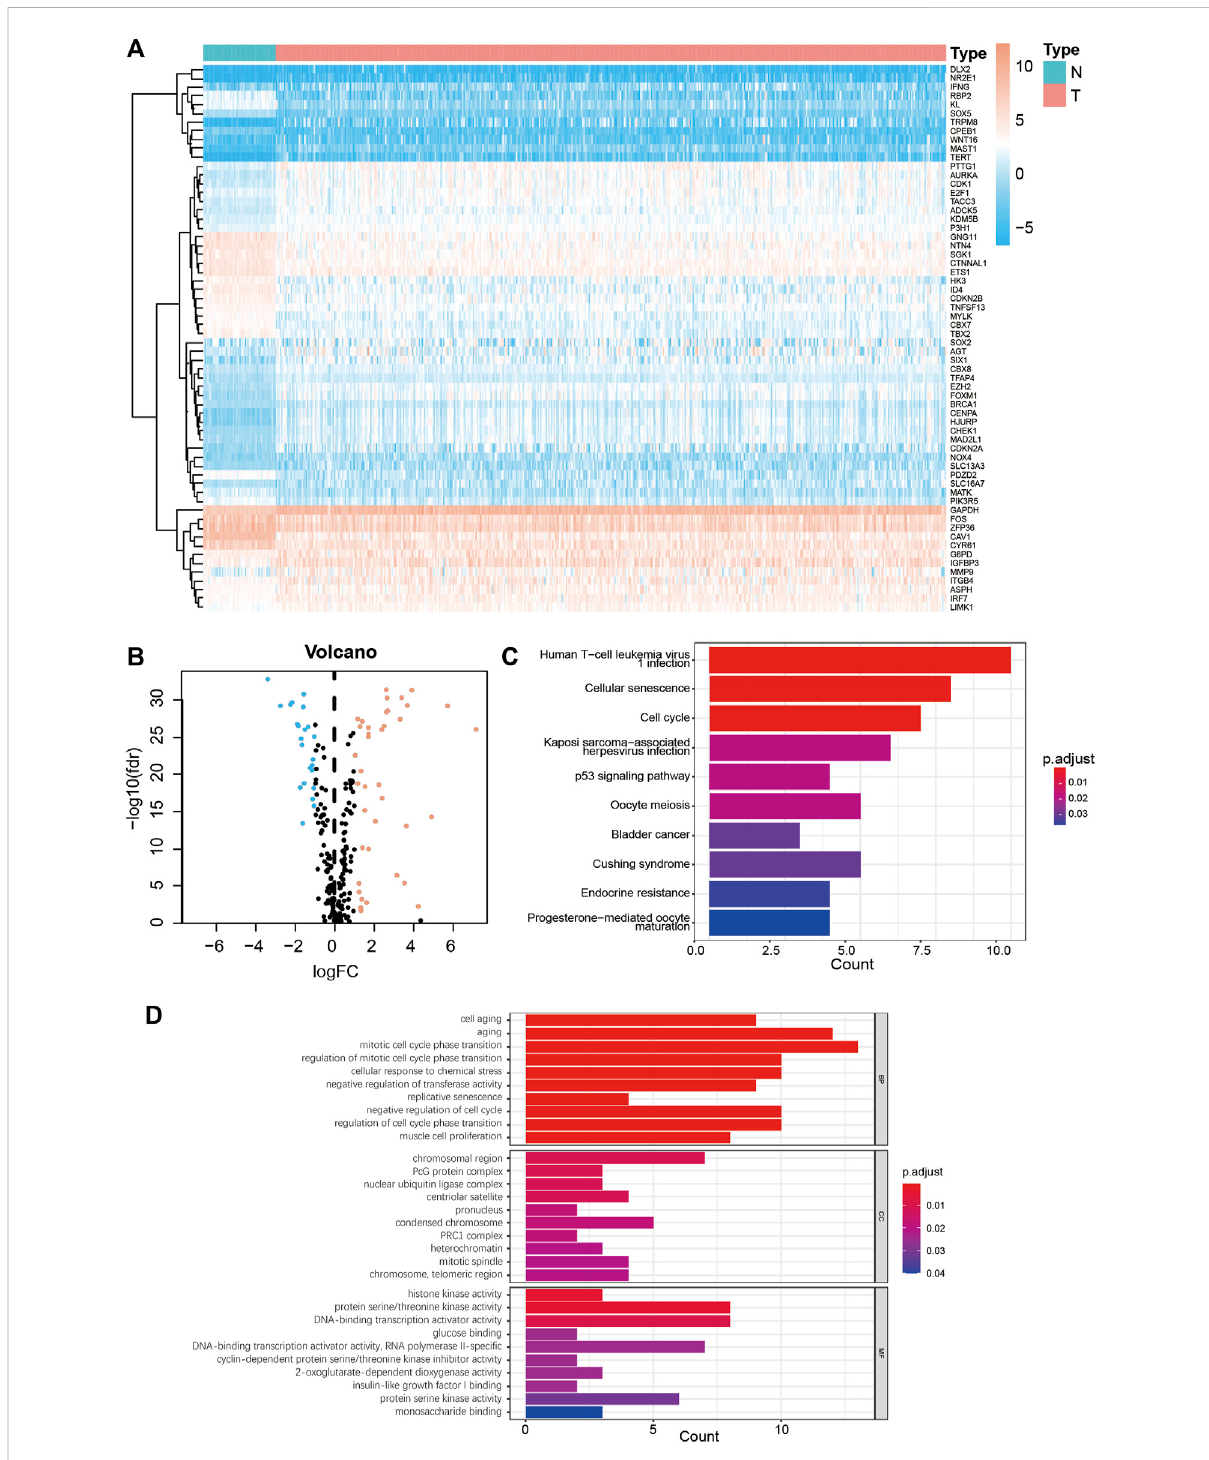
FIGURE 2 Enrichment analysis of senescence DEGs in LUAD. (A) Heatmap of 62 senescence DEGs in normal and LUAD tumor tissues. (B) Volcano plot of 279 senescence genes in normal and LUAD tumor tissues. Pink dots represent genes that have been upregulated in tumor tissues and blue dots representgenesthathavebeendownregulatedintumortissues. (C) KEGGanalysisofsenescenceDEGs. (D) GOanalysisofsenescenceDEGs.DEGs, differentiallyexpressedgenes;LUAD , lungadenocarcinoma;N,normaltissues; T,tumortissues;FC,foldchange;KEGG,KyotoEncyclopedia of Genes and Genomes; GO, Gene Ontology; FDR, false detection rate; BP, biological process; CC, cellular components; MF, molecular